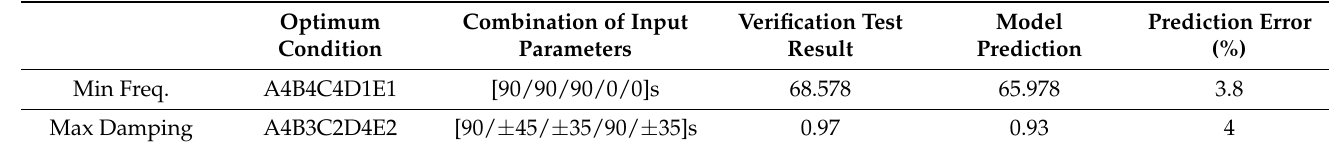
Table 5. Comparison between the verification test result and additive model prediction.